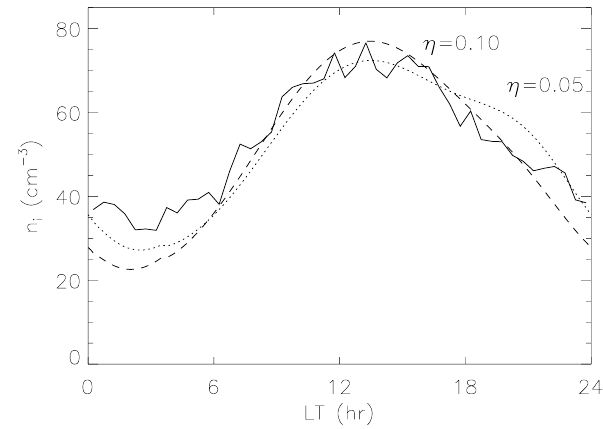
Fig. 6. Comparison between observations and model. The solid line is the 75th percentile level, the dotted line is the MSKPM prediction with η = 0 . 05 reduced by a factor of 2.9, and the dashed line is with η = 0 . 10 reduced by a factor of